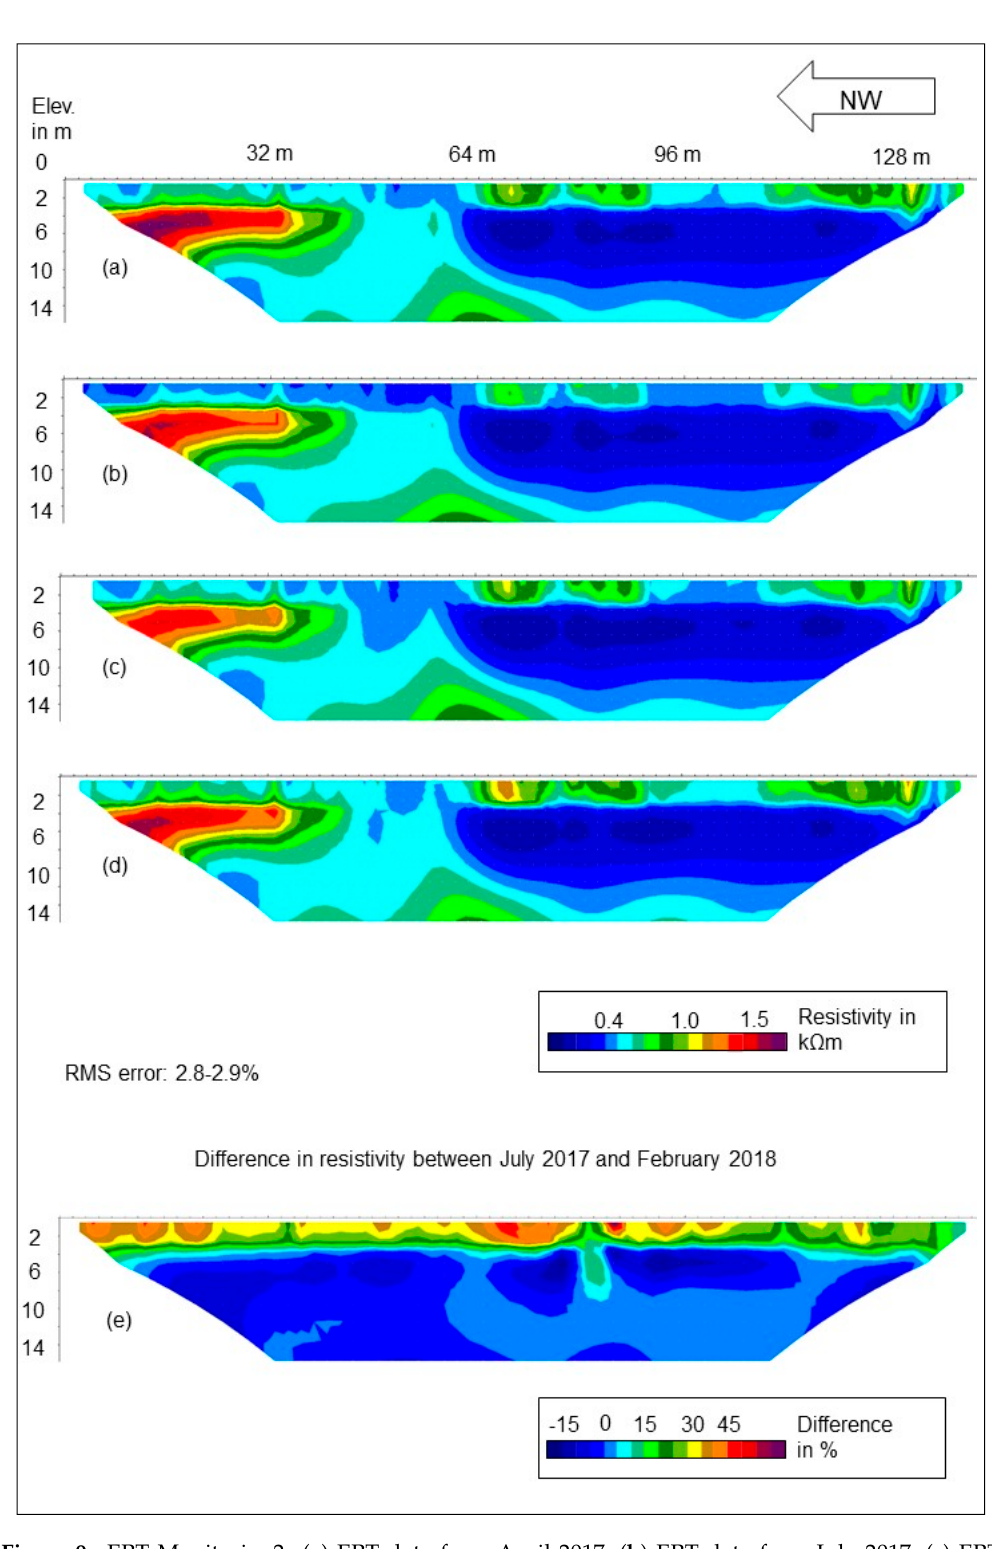
Figure 9. ERT Monitoring2: ( a ) ERT data from April 2017, ( b ) ERT data from July 2017, ( c ) ERT data from November 2017, ( d ) ERT data from February 2018, ( e ) percentage difference between July and February.